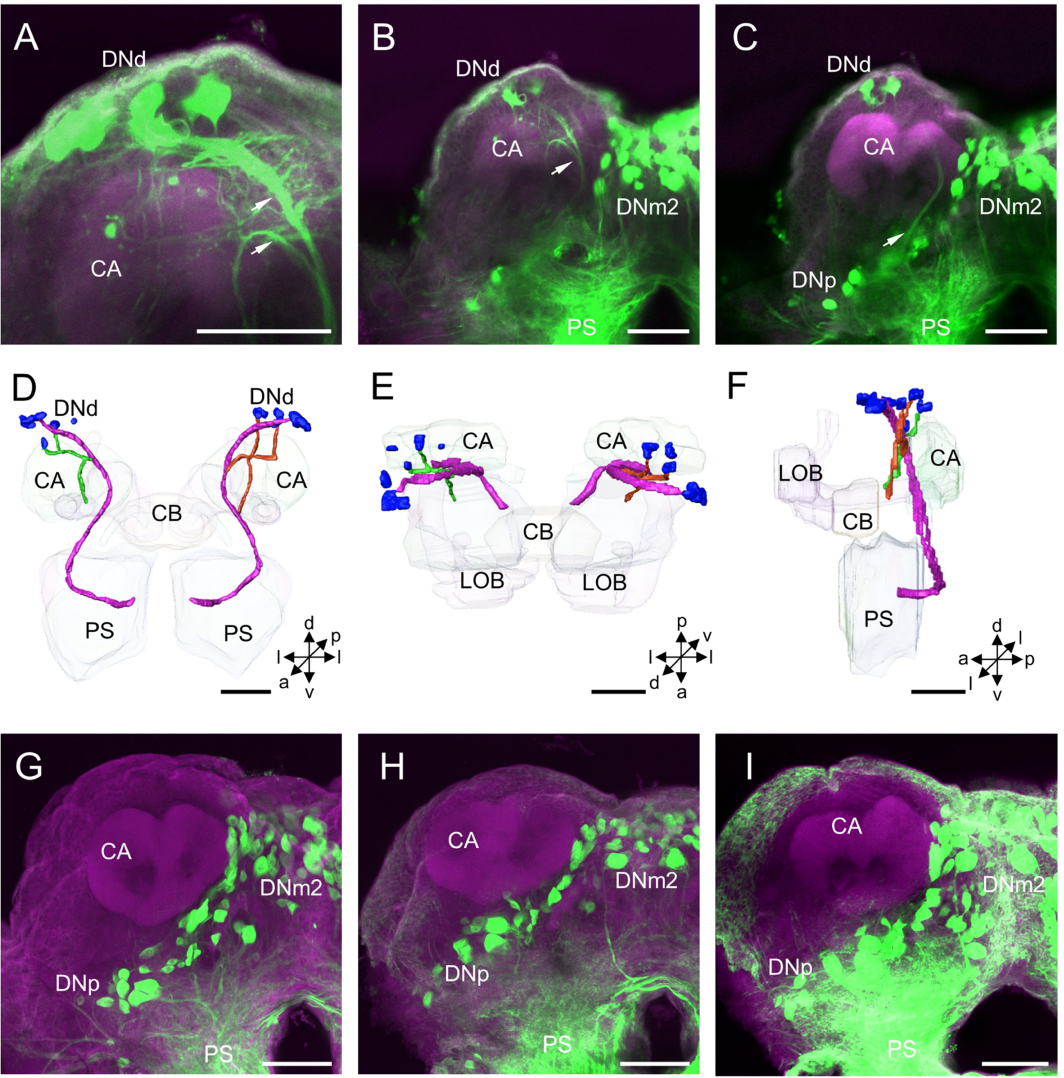
Figure 3. Distribution and projection patterns of DNd neurons in the brain: ( A – C ) projection views of confocal stack images showing DNd somata and primary neurites (arrows) in the brain of male H. armigera ; ( D – F ) the anterior, dorsal, and lateral views of the three-dimensional reconstruction showing DNd somata and primary neurites in the brain of male H. armigera ; and ( G – I ) Three preparations of the female brain were successfully labeled by backfilling, showing no stained DNd neurons in the female brain. CA, calyx; CB, central body; LOB, mushroom body lobes; PS, posterior slope. a, anterior; d, dorsal; l, lateral; p, posterior; v, ventral. Scale bars: 100 μ m.